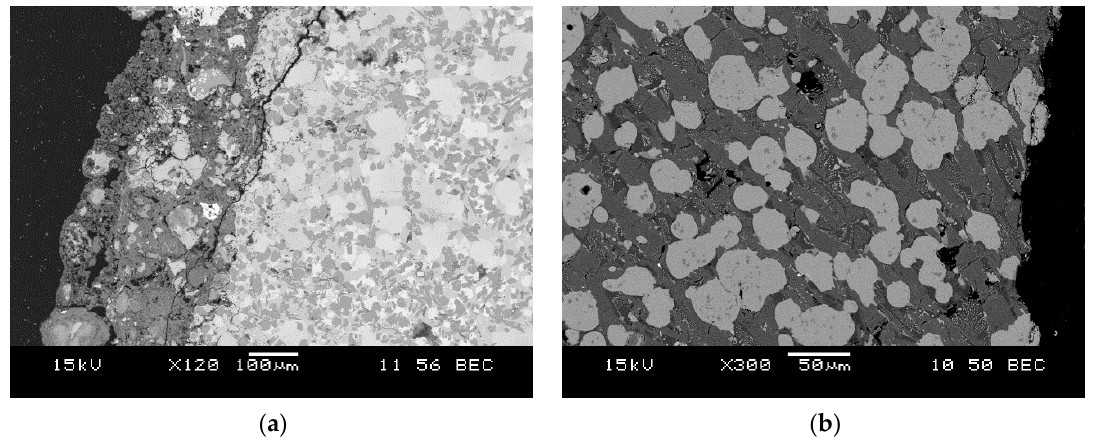
Figure 1. Compositional BSE micrographs at the edge of a ( a ) BOF slag and ( b ) EAF slag particle. The BOF slag particle exhibited a surface composition that was compositionally different from the interior of the particle, whereas the EAF slag particle appeared to have similar surface and interior